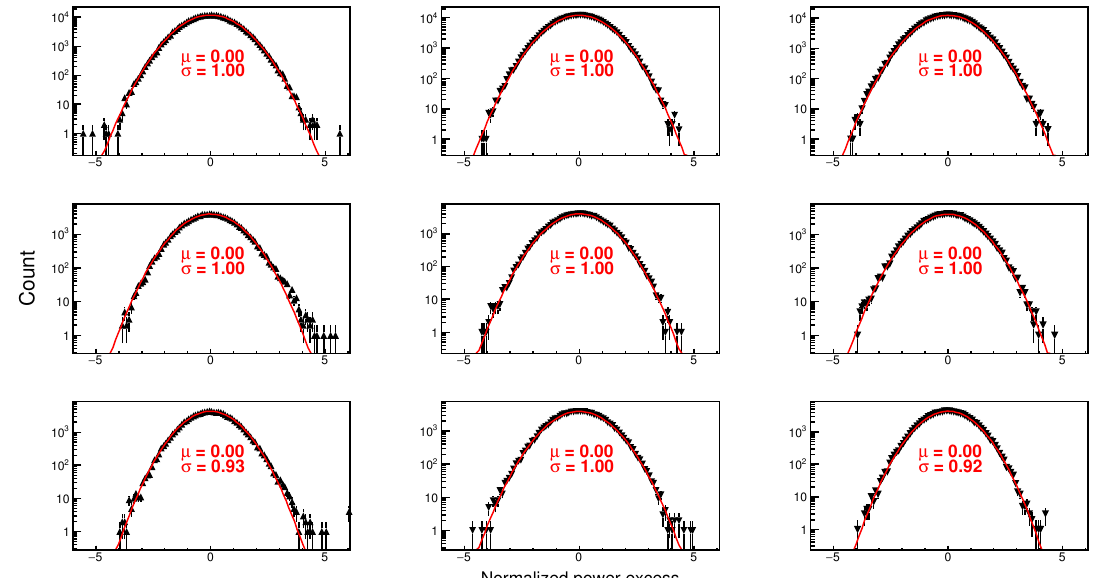
Figure 4 . Distributions of the normalized power excess from the CAPP-8TB experiment (triangles in the 1st column), and from a single simulated axion haloscope search experiment with CAPP- 8TB backgrounds and axion signals at a particular frequency (inverted triangles in the 2nd and 3rd columns). Distributions in the 2nd column were obtained after subtracting the background with perfect fit, while those in the 1st and 3rd columns were with a 5-parameter fit. From top to bottom row, they are the distributions after the Step-1, Step-2, and Step-3 procedures, respectively. Lines are a Gaussian fit resulting in µ and σ with negligible fit errors of O (10 − 3 ) .